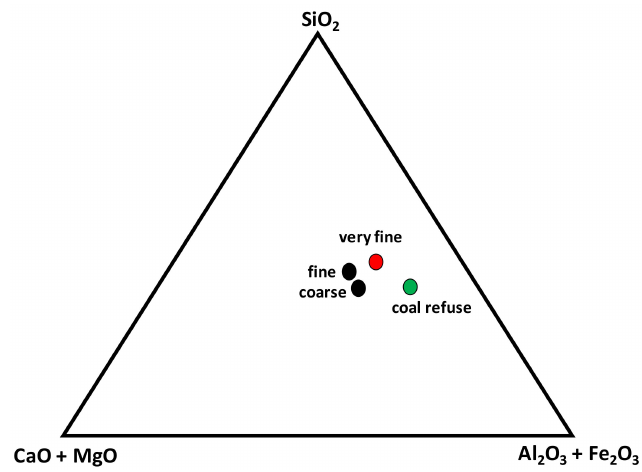
Figure 6. Triangular diagram from the mayor elements in the tailings and coal